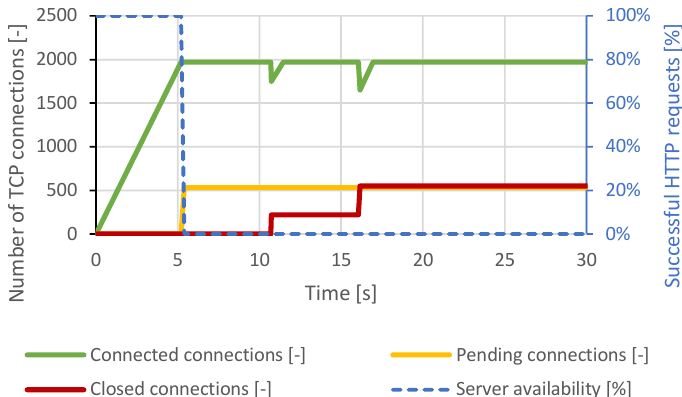
Figure 10. Slow Read attack against Nginx server.